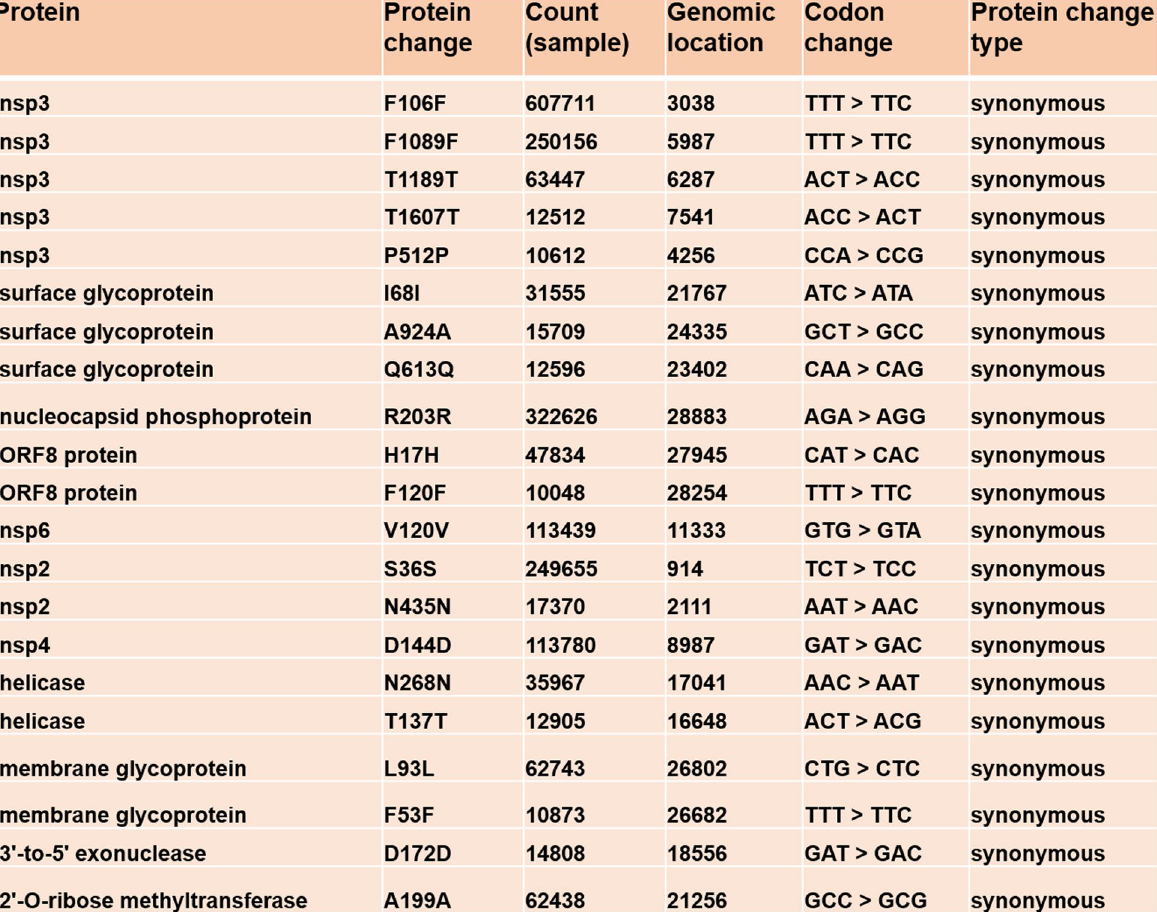
Table 2 Major hotspot mutant genes with synonymous mutation, codon, and protein changes with mutation sites of the